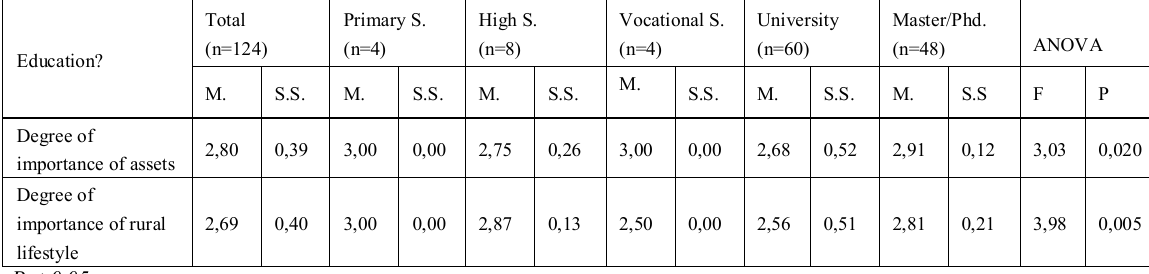
Table 6: Effect of Education to Different